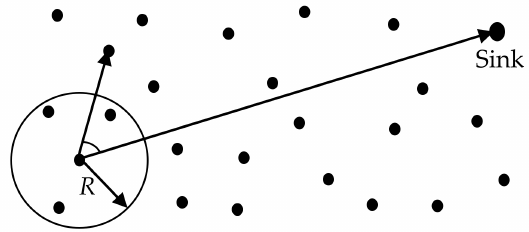
Figure 2. The searching